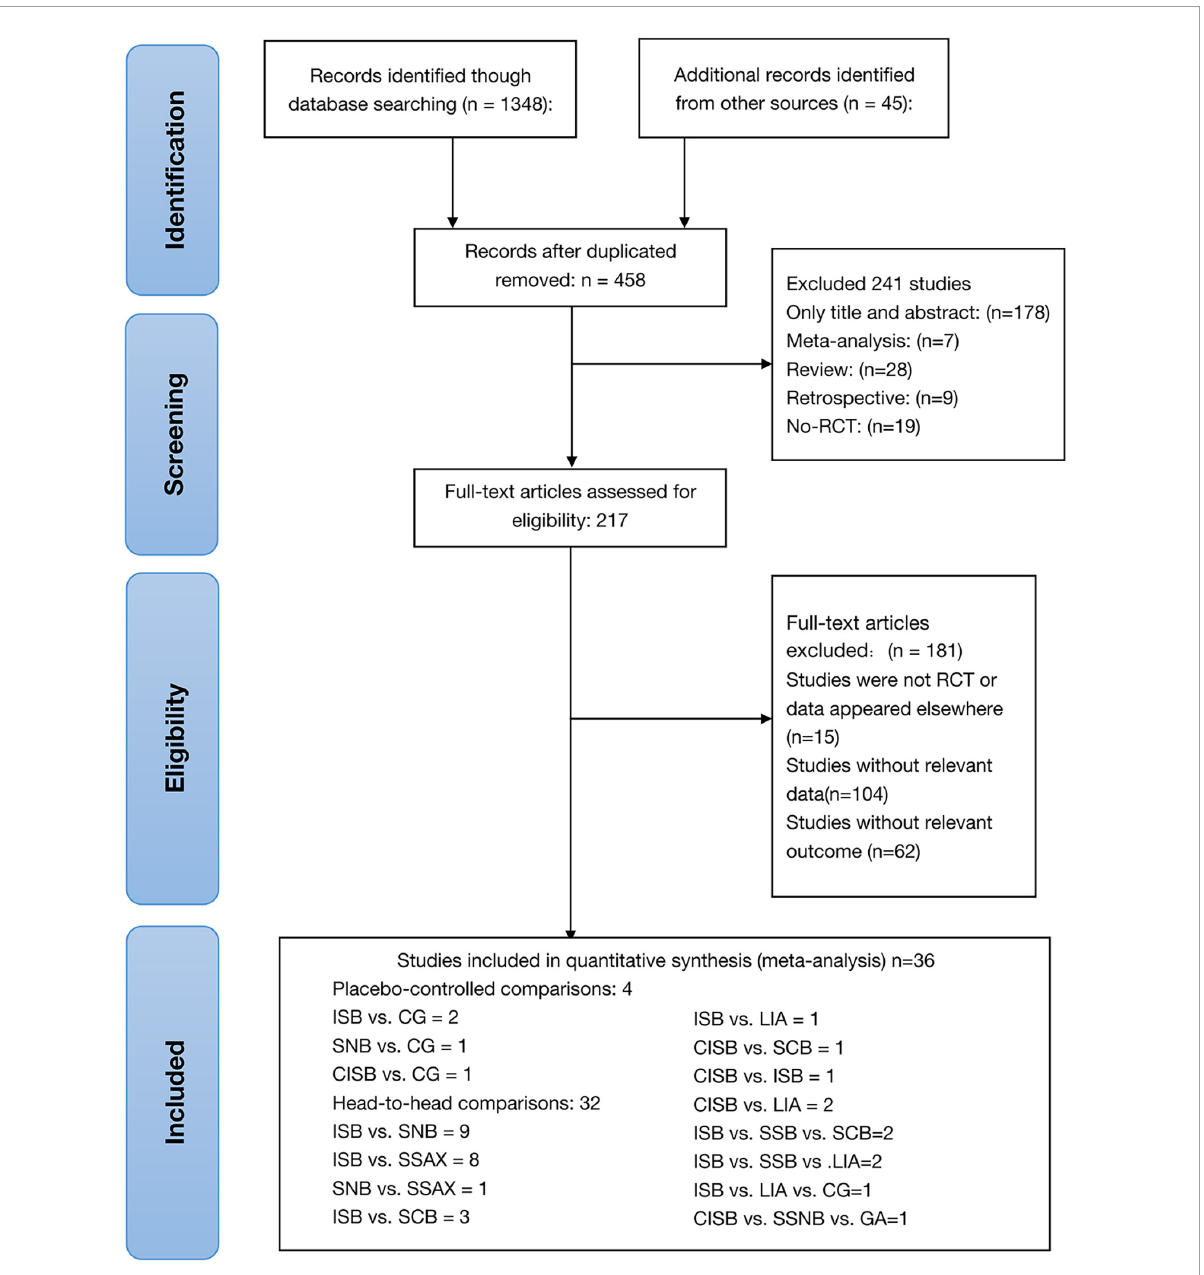
FIGURE1 Literature review flowchart; RCT, Randomized controlled; CG, Control group.